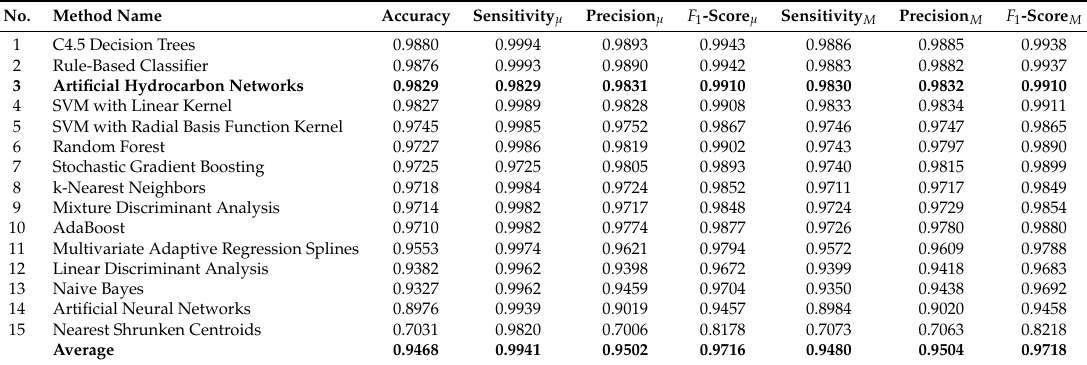
Table 6. Comparison of the supervised classifiers using the complete dataset of the case study. No. Method